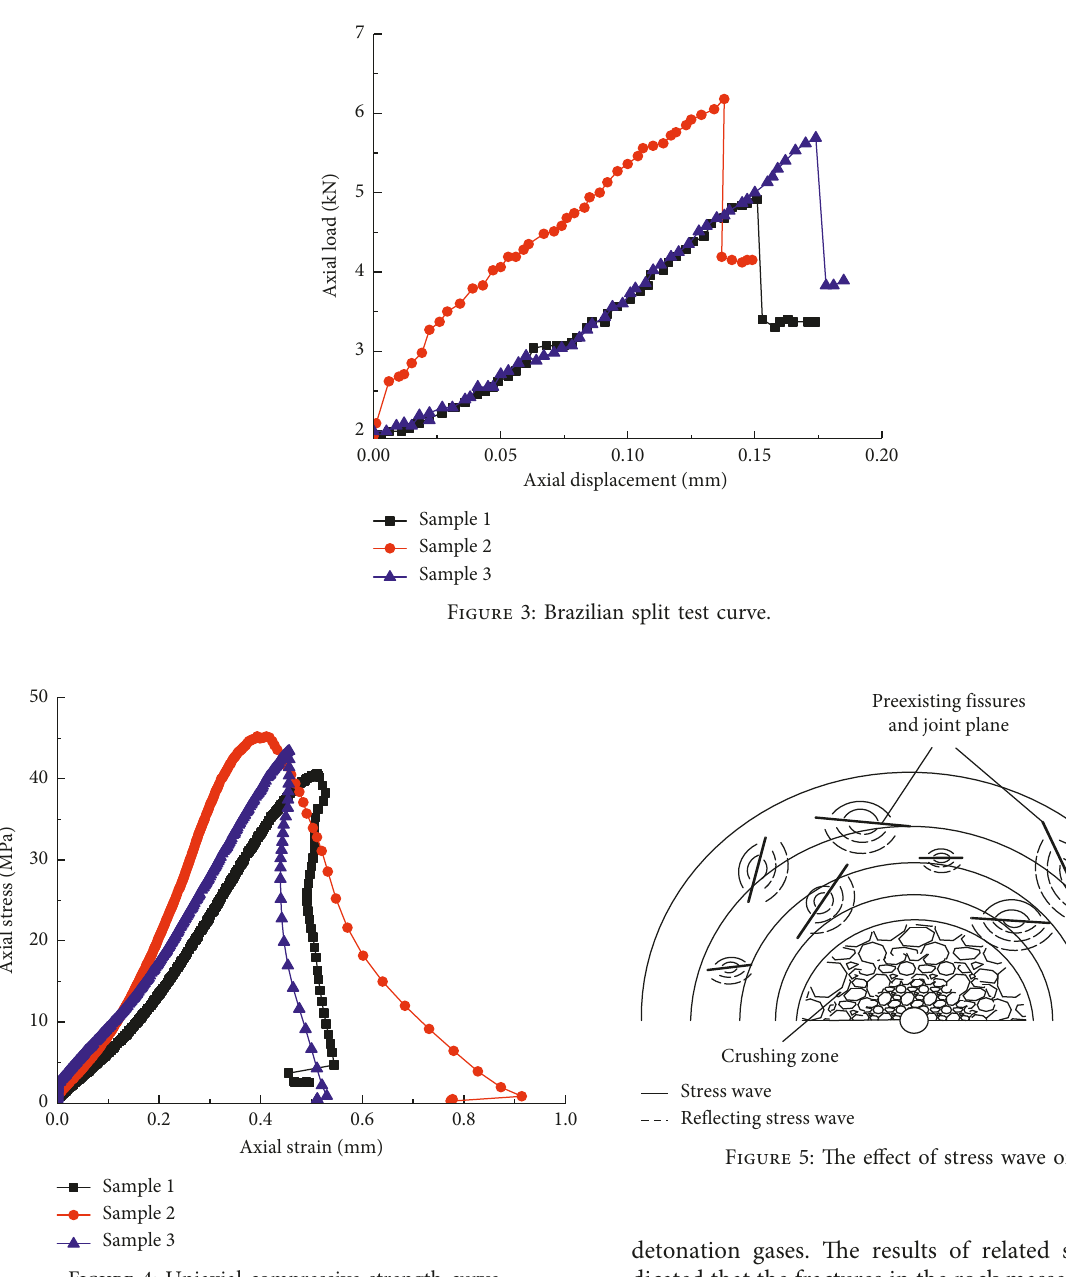
Figure 4: Uniaxial compressive strength curve.